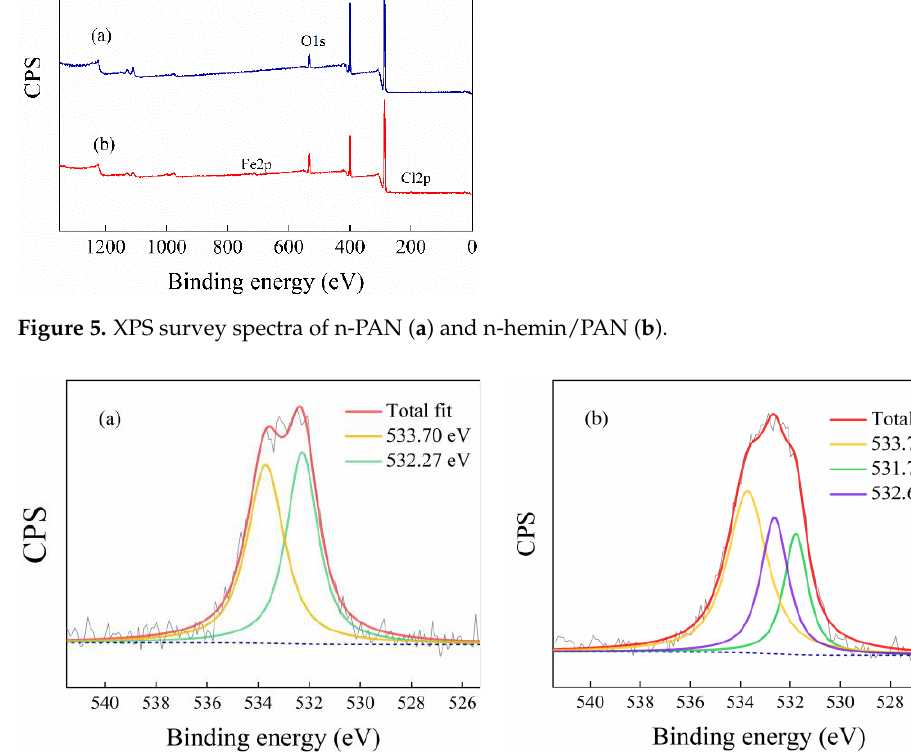
Figure 5. XPS survey spectra of n-PAN ( a ) and n-hemin/PAN ( b ). Figure 6. XPS O1s spectra of n-PAN ( a ) and n-hemin/PAN ( b